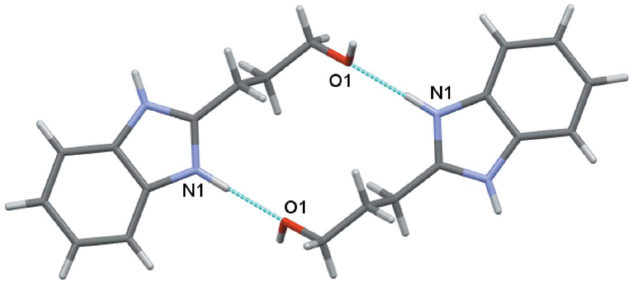
Figure 4 Hydrogen-bonded centrosymmetric dimer of the cations in the nitrate salt. Hydrogen bonds are shown by the cyan lines.